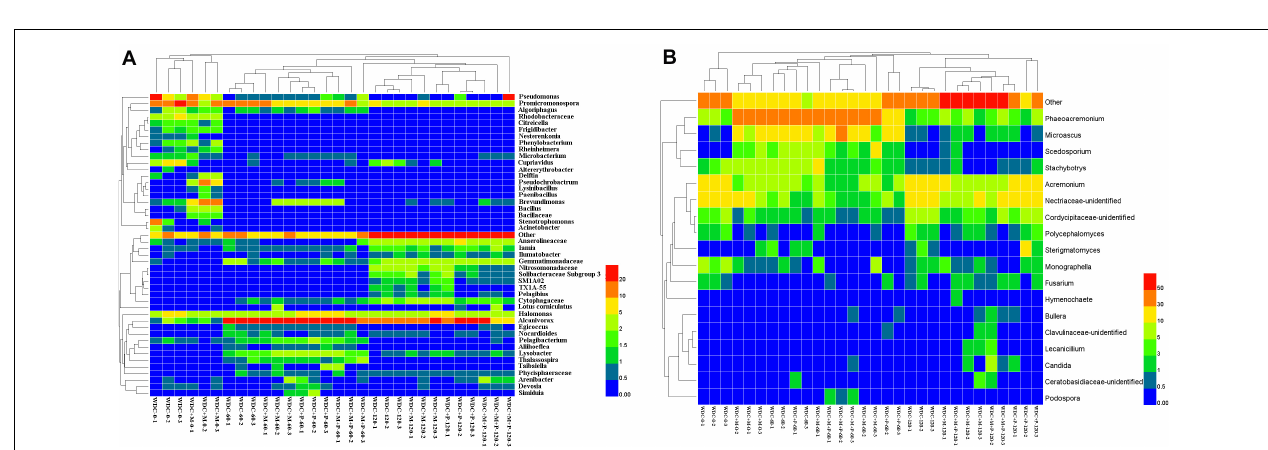
FIGURE 5 | Differences in bacterial (A) and fungal (B) community composition over time in waste drill cuttings (WDCs). WDCs were incubated in a greenhouse for 120 days with and without black locust ( Robinia pseudoacacia ) plant and with or without bacterial and fungal consortium inoculant. The differences are based on Bray–Curtis dissimilarities and tested using permutational multivariate analysis of variance (PERMANOVA). ** P < 0.01.